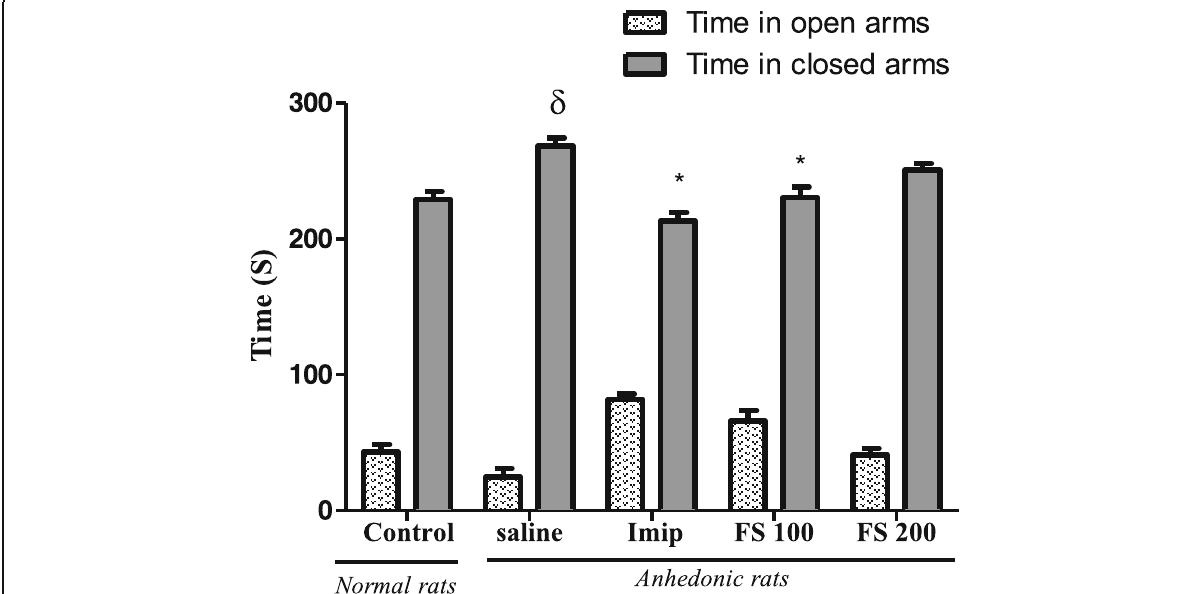
Fig. 9 Effect of F. sycomorus extract on the time spend in open and closed arms. Values are mean ± SEM (n = 6). * P < 0.05 compared to control. γ P < 0, 05 vs. anhedonic rats treated with saline